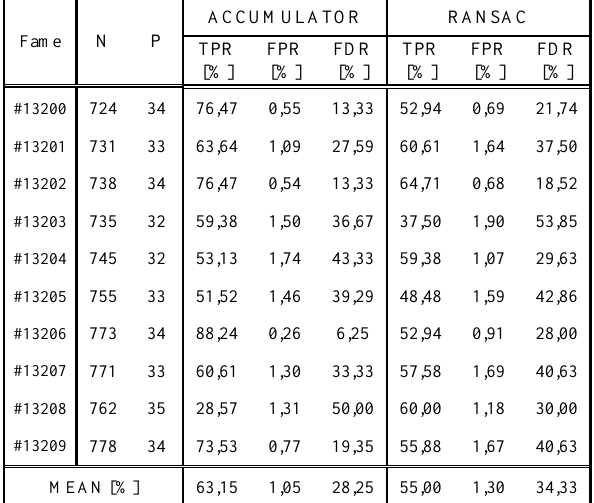
Table 1. Evaluation and comparison of outlier detectors. N - all possible correct negative matches, P – all possible positive matches, TPR - true positive rate, FPR – false positive rate, FDR – false discovery rate.